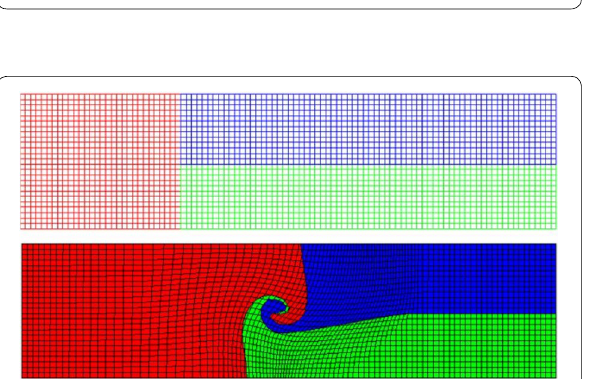
Figure 6 Comparison between the main domain and the Eulerian formulation